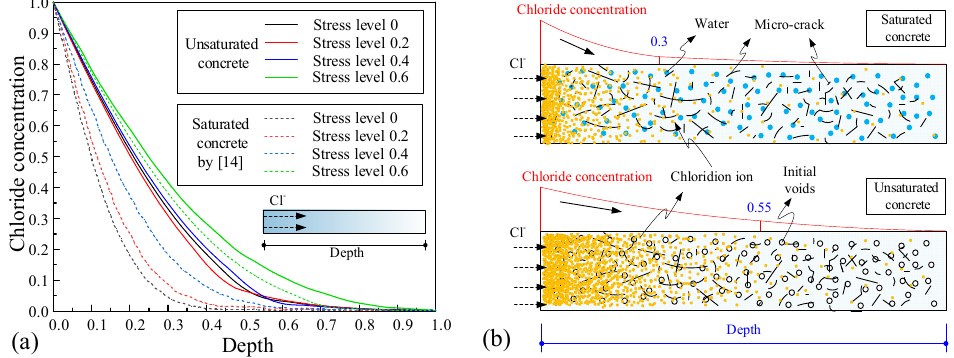
Figure 10. Chloride transport in unsaturated and saturated concrete under repeated loading: ( a ) normalized comparison and ( b ) schematic diagram.